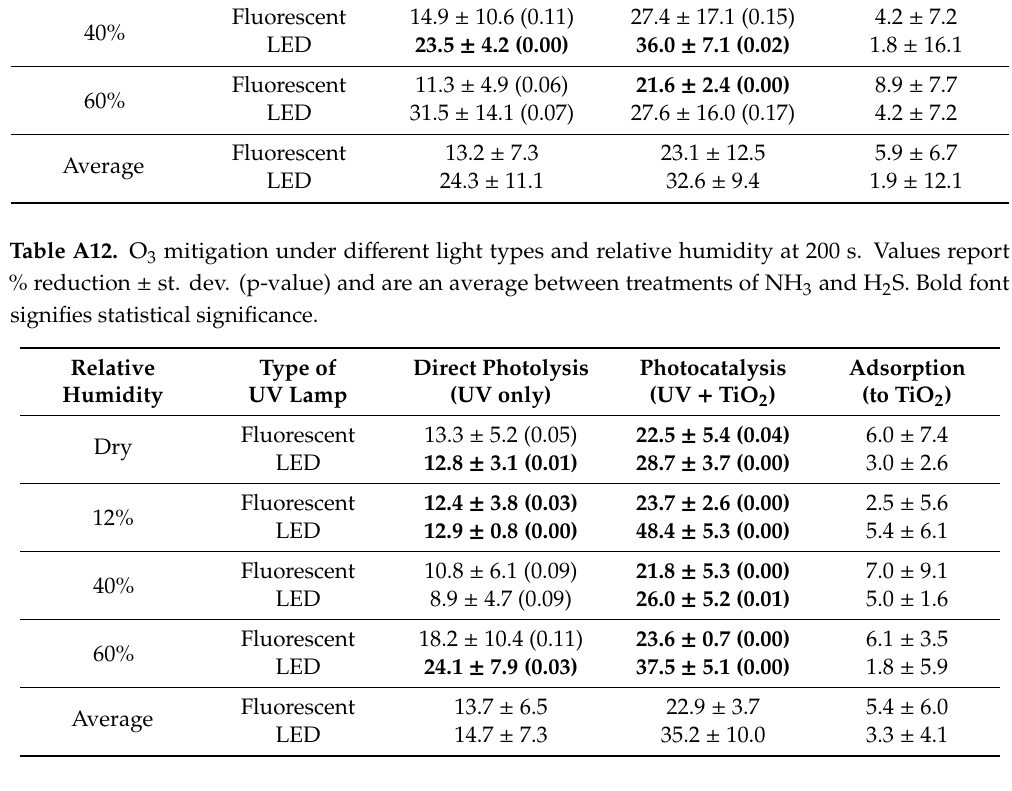
Table A13. O 3 mitigation under the di ff erent dust levels at a relative humidity of dry and 12% in direct photolysis. Value in the table report % reduction ± standard deviation ( p -value) and are an average between treatments of NH 3 and H 2 S standard gases. Bold font signifies statistical